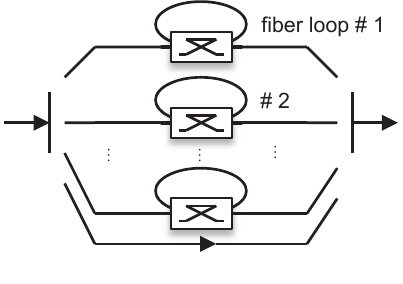
Figure 1: Parallelly-arranged loop optical